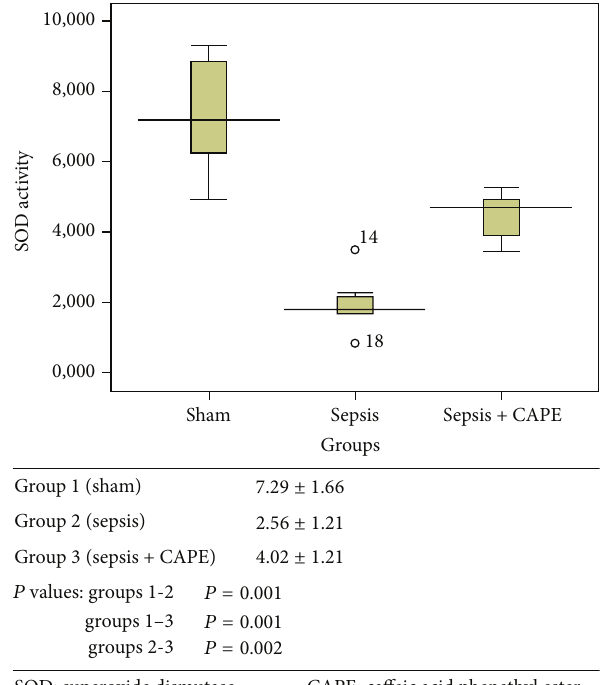
Figure 4: Tissue SOD activity (U mg −1 protein) was described as mean value ± SD for all